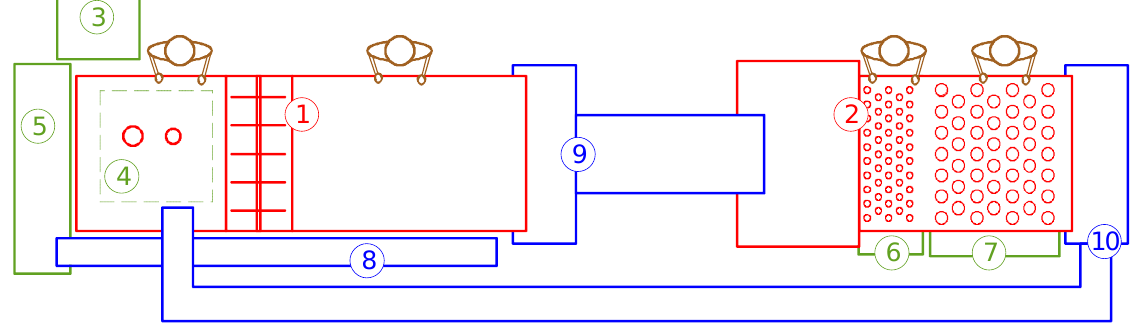
Figure 3. Schematic diagram of a processing line for cauliflower and broccoli floretting: 1 — crusher, 2 — calibrator, 3 — container for whole inflorescences, 4 — container for stalks, 5 — container for leaf 2—calibrator, 3—container for whole inflorescences, 4—container for stalks, 5—container for leaf fragments, 6 — container for excessively crushed florets, 7 — container for appropriately sized fragments, 6—container for excessively crushed florets, 7—container for appropriately sized florets, florets, 8 — conveyor belt for unqualified semi-processed products, 9 — conveyor belt for qualified 8—conveyor belt for unqualified semi-processed products, 9—conveyor belt for qualified semi- semi-processed products, 10 — conveyor belt for oversized florets. processed products, 10—conveyor belt for oversized